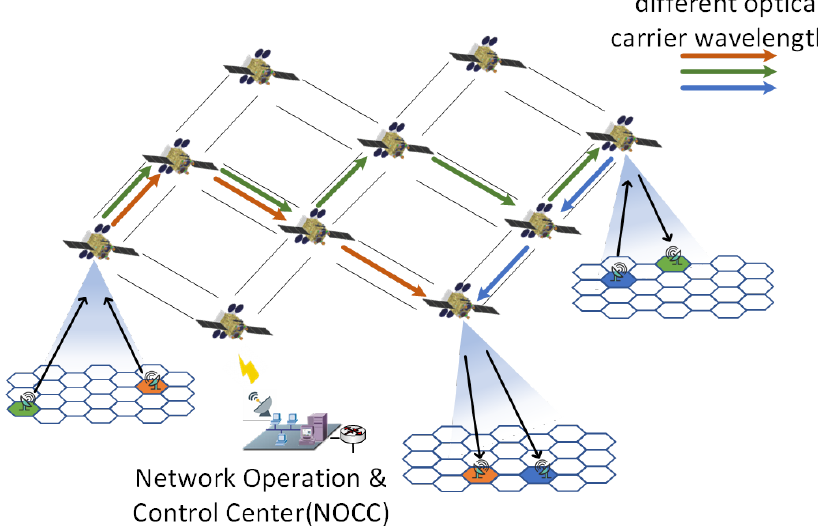
Figure 2. Wavelength Assignment and